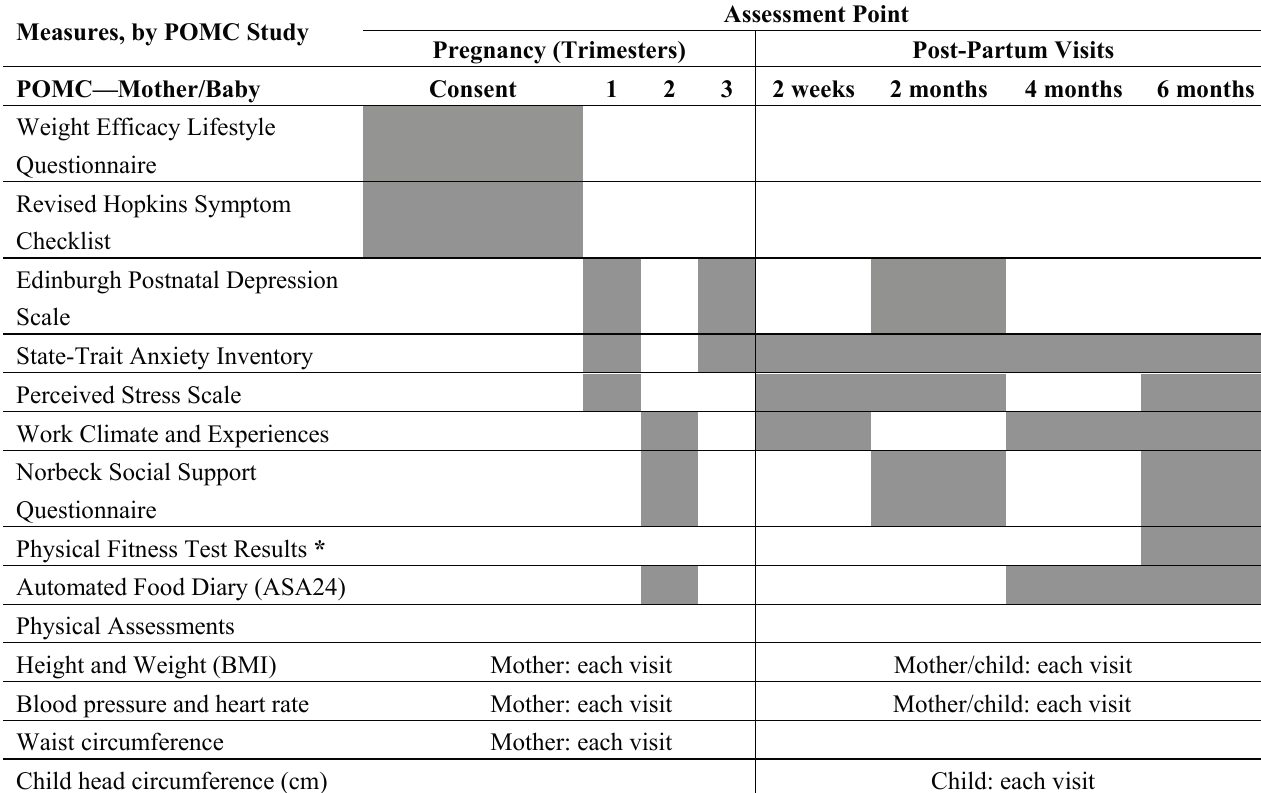
Table 1. Assessment